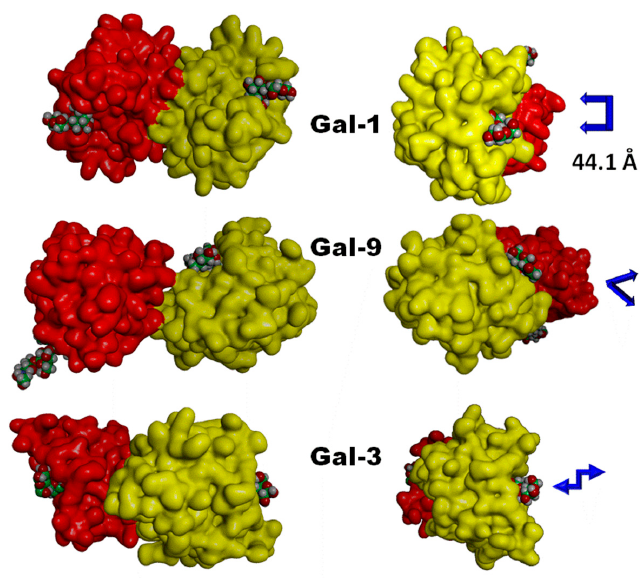
Figure 9. Relative spatial orientation of CRDs of galectins, which can be differently responsible for intra/inter-cellular cross-linking ( left : face view; right : lateral view). Blue arrows point the positioning of two CRDs.